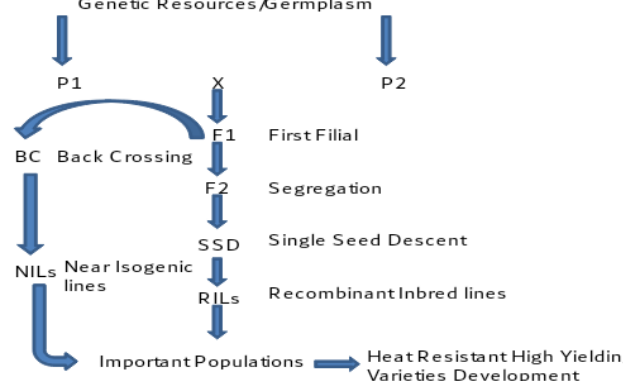
Figure 6. Genetic resources are a vital component for the improvement and development of new hybrid rice high-yielding varieties.